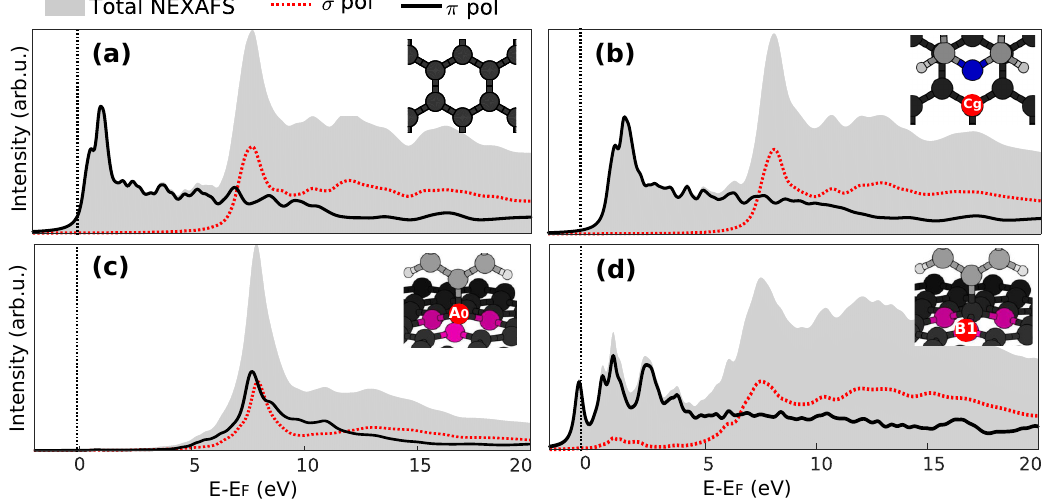
Figure 4. Total NEXAFS spectra at the C 1s edge and the components resolved depending on the photon electric field direction ( p -polarization, transition to π states, s -polarization, transition to σ states) for ( a ) pristine graphene; ( b ) a C atom of graphene (C g ) close to the physisorbed pyridine ( c ). The bonding C atom of graphene participating in the covalent bond with the pyridine radical (A 0 site), and ( d ) a nearest neighbor C atom of the bonding site (B 1